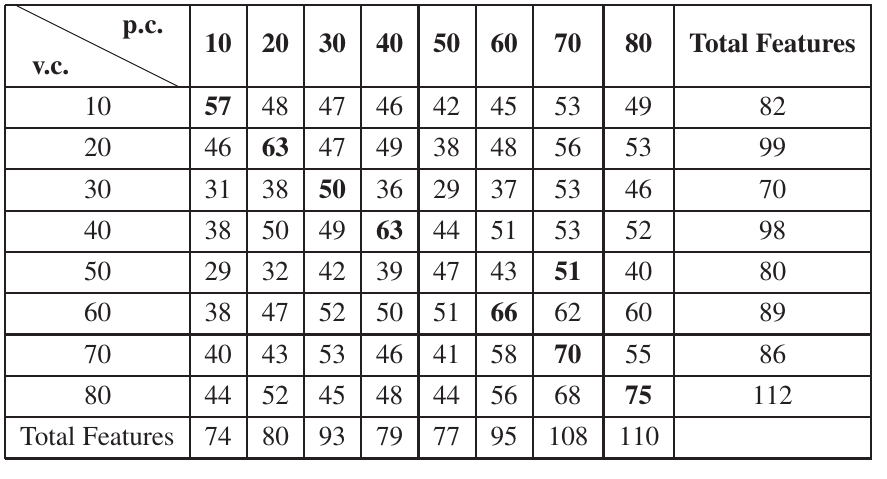
Table 1. SIFT feature detection and matching for the perspective camera (p.c.) and virtual camera (v.c.) with various focal lengths.